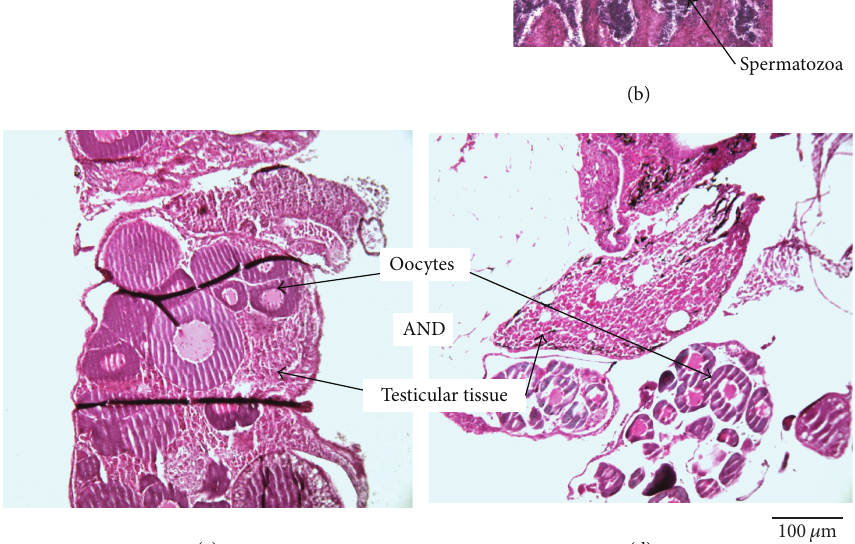
were not very common